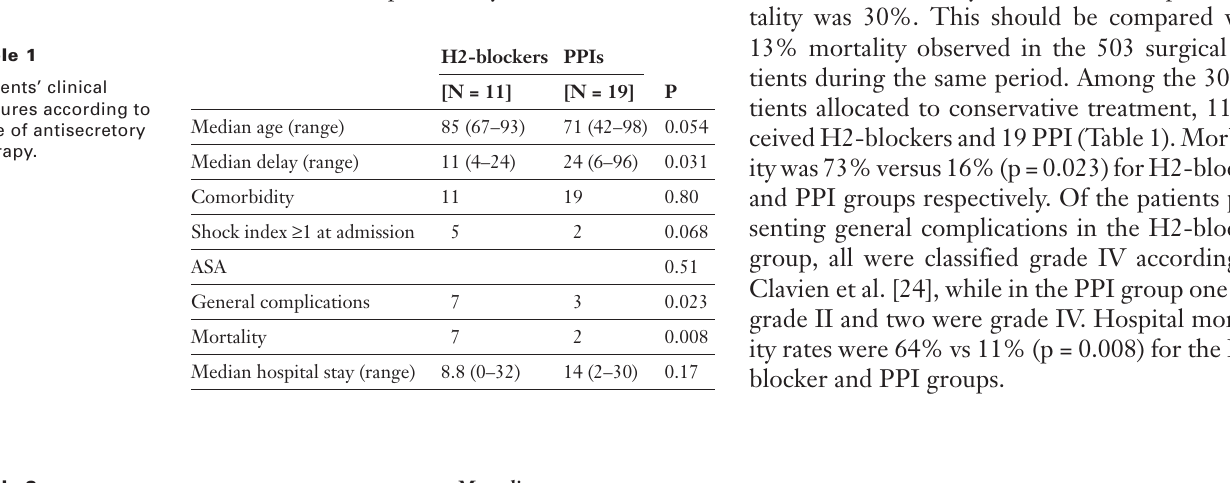
Relation between mortality and clinical variables among all